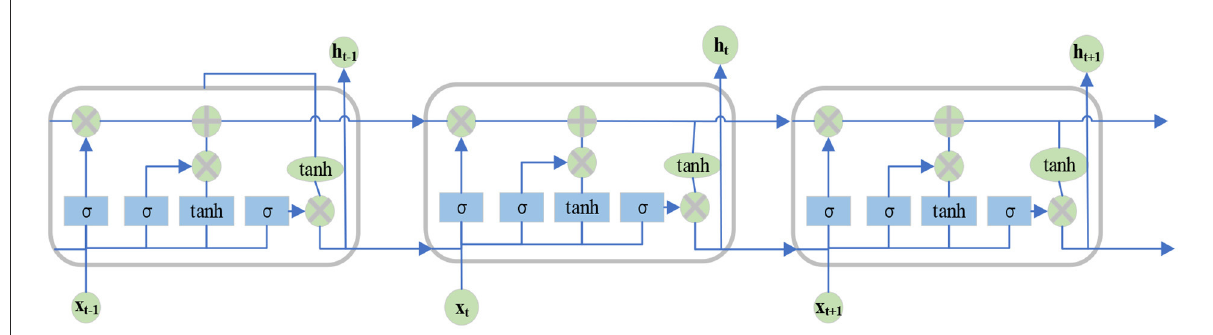
FIGURE2 Schematic diagram of LSTM network structure.